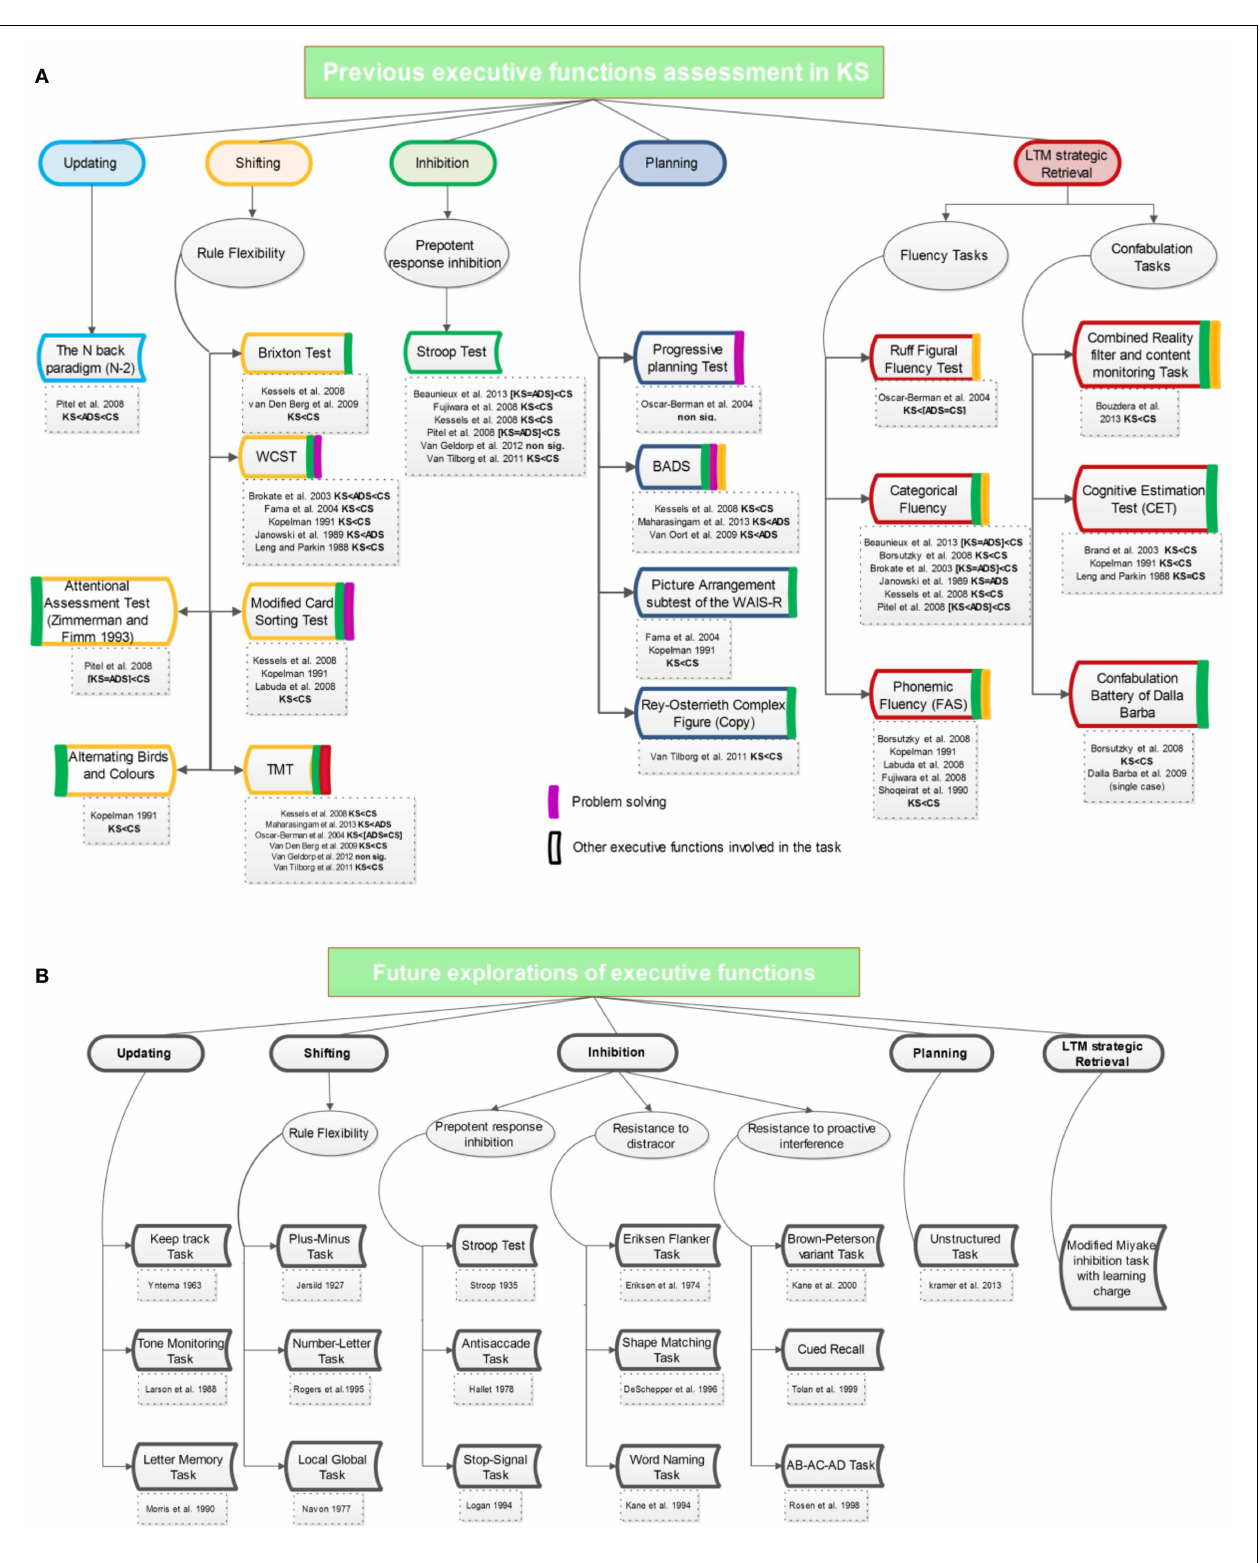
indicate the overlap between EF subcomponents and problem solving (a complex and transversal EF involved in several tasks). (B) Overview of the EF assessment program proposed by Miyake et al. (2000) and Friedman and Miyake